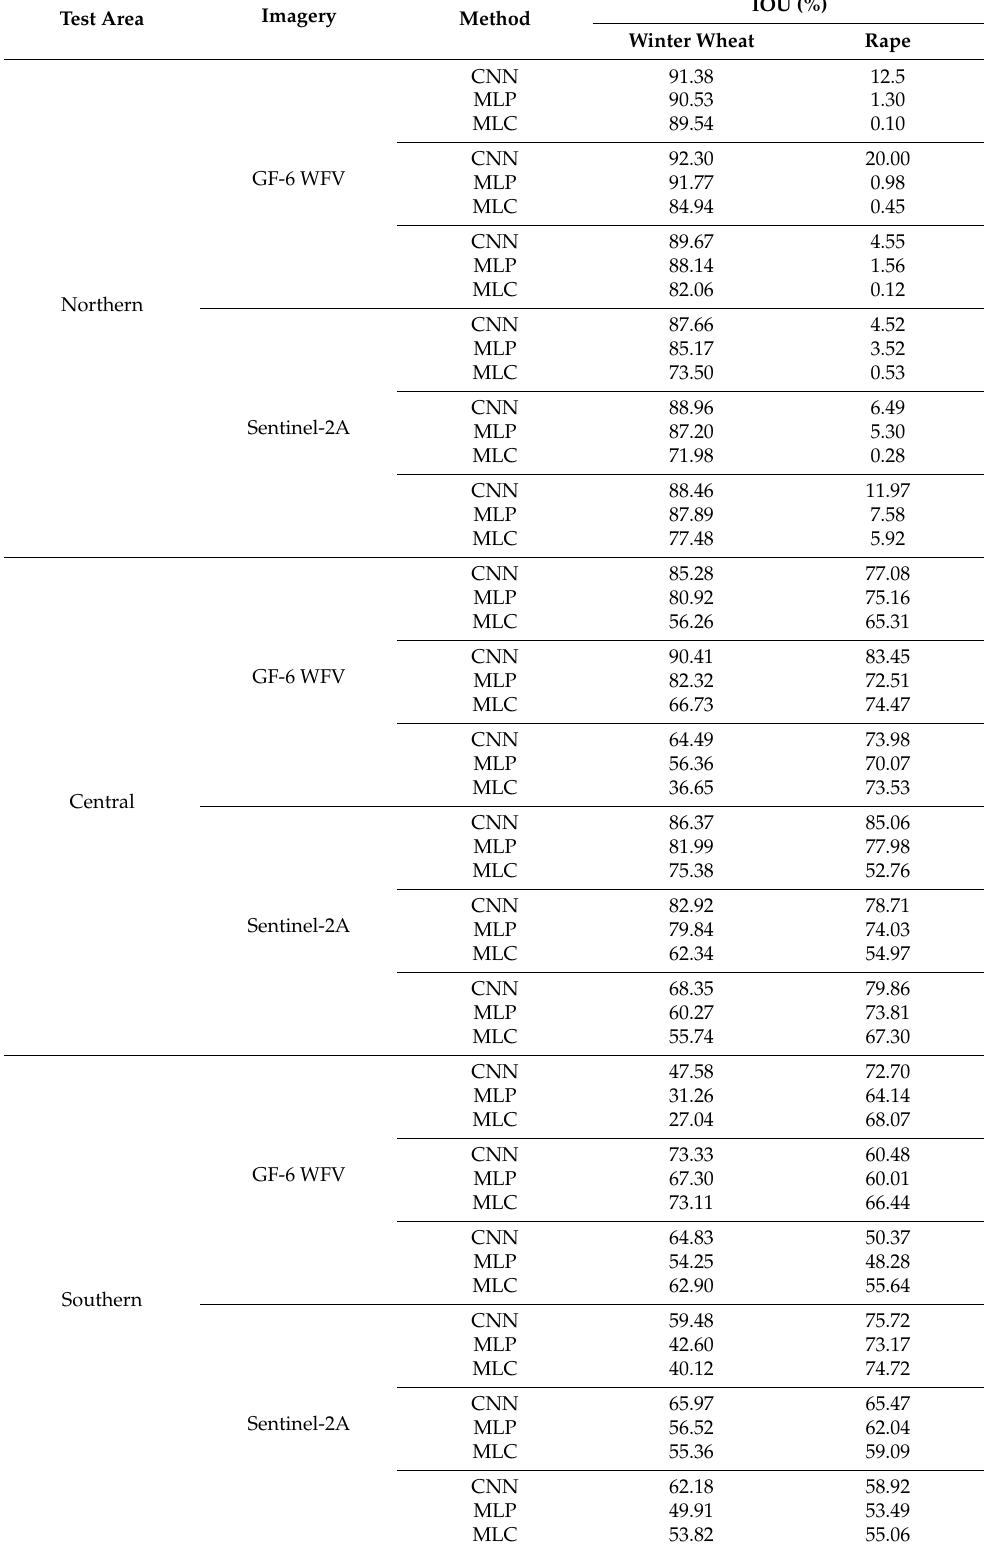
Table 16. IOU results of GF-6 WFV and Sentinel-2A data using different